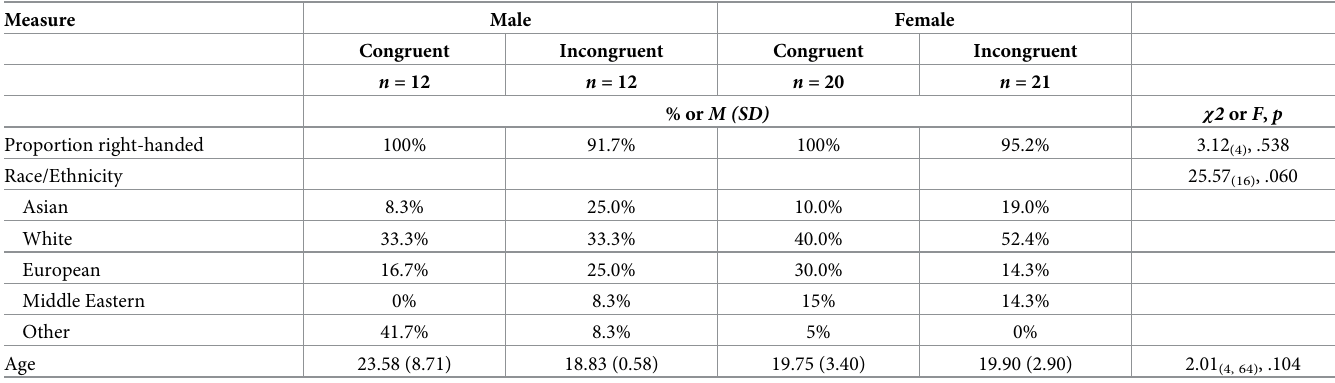
Table 1. Participant demographic characteristics by experimental condition in Study